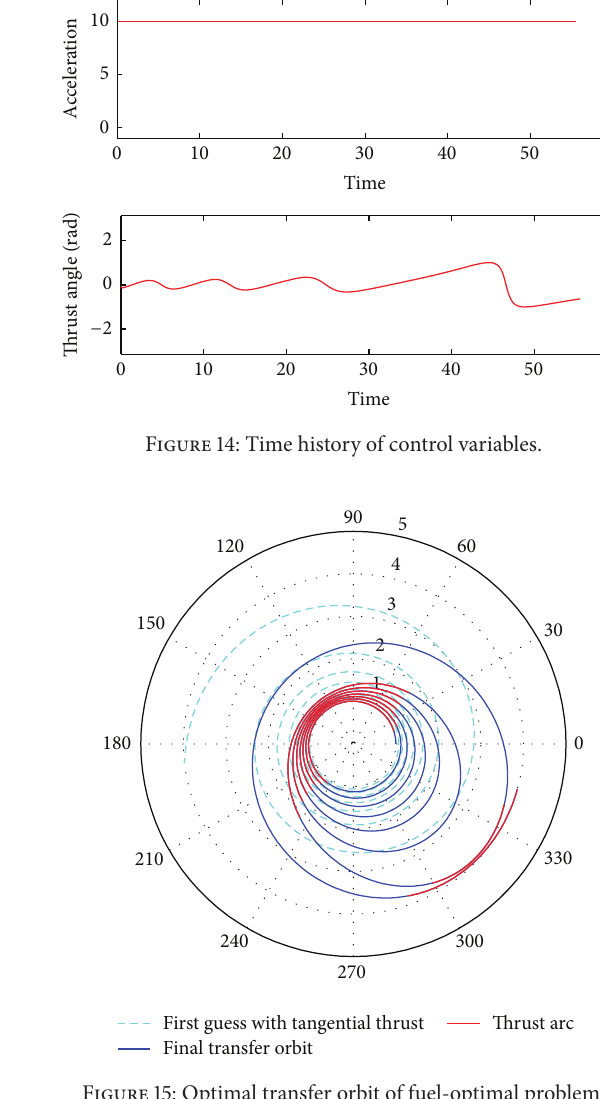
Figure 12: Optimal transfer orbit of time-optimal problem.